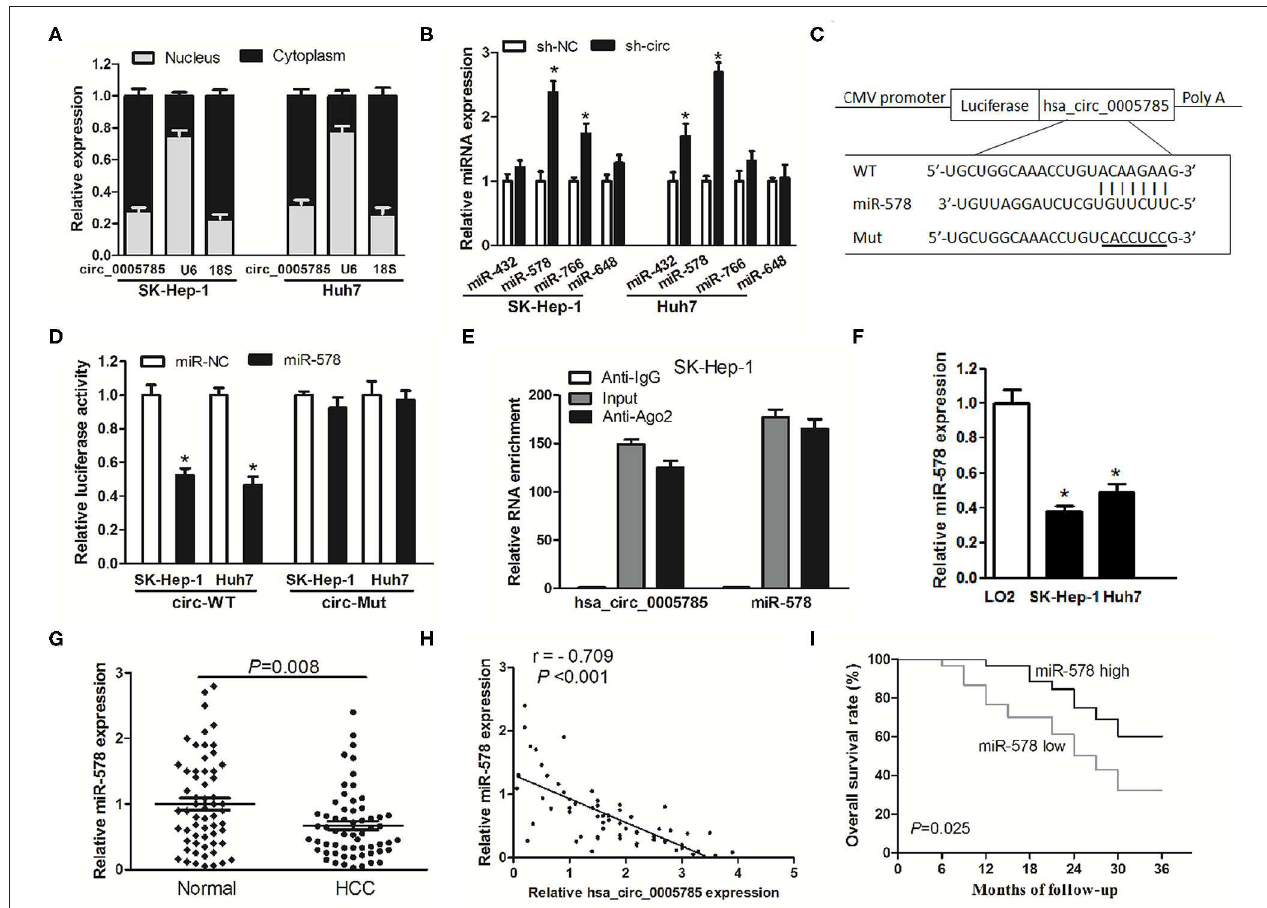
FIGURE 5 | hsa_circ_0005785 directly binds to miR-578. (A) qRT-PCR detection of the cytoplasm and nucleus levels of hsa_circ_0005785 in SK-HEP-1 cells and Huh7 cells, 18S rRNA and U6 as cytoplasm and nucleus controls, respectively. (B) The expression of 4 predicted targeting miRNAs of hsa_circ_0005785 in sh-NC or sh-circ-treated two HCC cell lines. (C) Bioinformatics software predicted the miR-578-binding sequence of hsa_circ_0005785, and its wild-type (WT) or mutant (Mut) miR-578-binding sequence was cloned into pMIR luciferase reporter. (D) The luciferase activity was analyzed in two HCC cell lines co-transfected with miR-578 mimic or miR-NC and circ-WT or circ-Mut. (E) RIP assay of cellular lysates from SK-HEP-1 cells with Ago2 antibody. hsa_circ_0005785 and miR-578 levels were detected by qRT-PCR. The fold enrichment was presented as Ago2 relative to IgG immunoprecipitates. (F) qRT-PCR analysis of miR-578 expression in SK-HEP-1, Huh7, and LO2 cells. (G) qRT-PCR detection of miR-578 expression in 60 HCC tissues and paired normal tissues. (H) The correlation analysis was conducted between hsa_circ_0005785 and miR-578 levels from 60 HCC tissues. (I) Kaplan–Meier curve analysis based on the miR-578 expression level of HCC patients, * P <